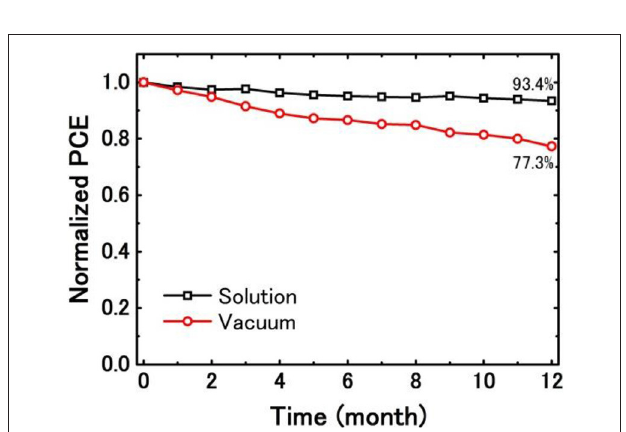
FIGURE 8 | Comparison of the degradation of normalized PCE of solution-processed DIBSQ:PC 71 BM SMBHJ cells and vacuum-processed DIBSQ:C 70 SMBHJ